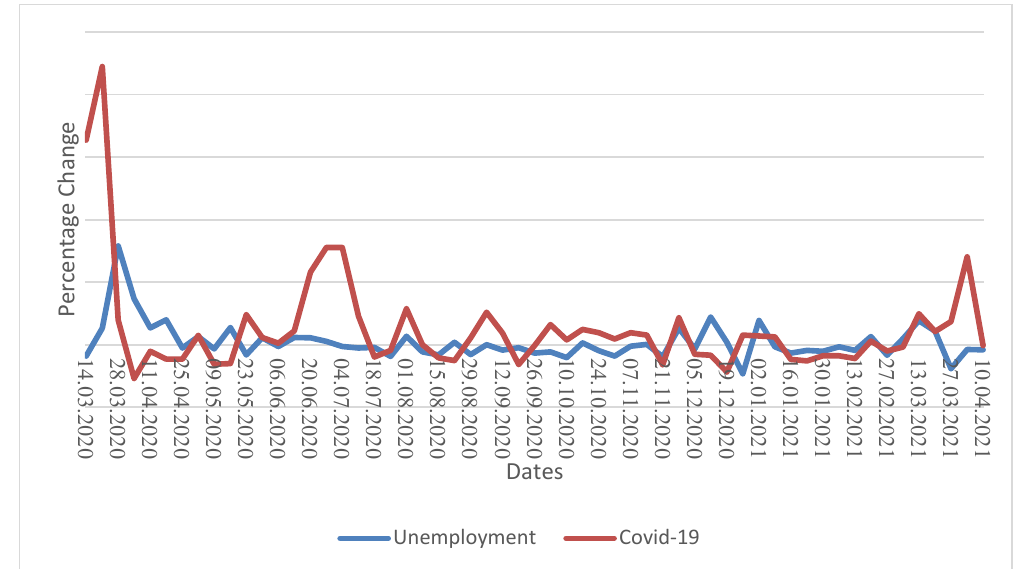
Fig. 2. Percentage change of the unemployment rate and the number of persons infected with